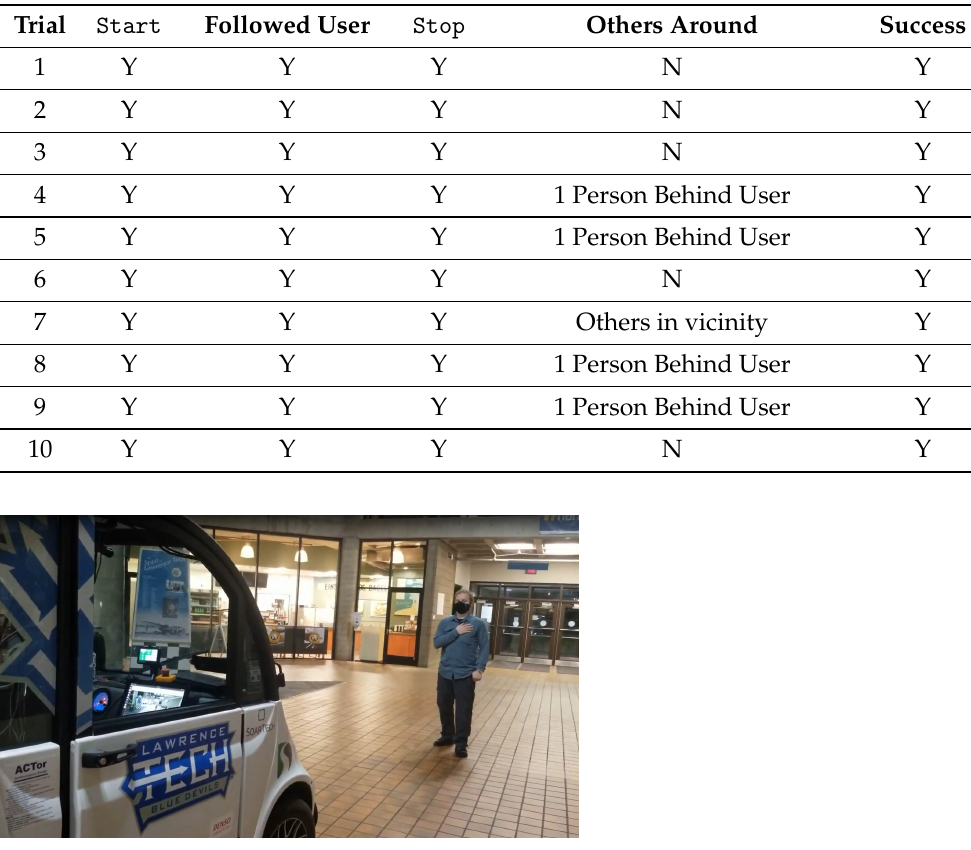
Table 3. Summary of experimental trials. We report 100% success of the gesture-driven LFA system. Unrelated ACTor 1 system failures and trials ended due to safety precautions were not counted.